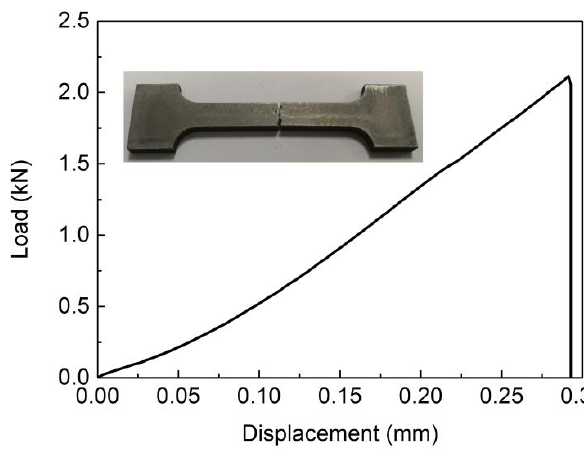
Figure 16. The displacement–load curve of Mo-10Ta under static tensile ( 286 K, 0.001 s −1 ).